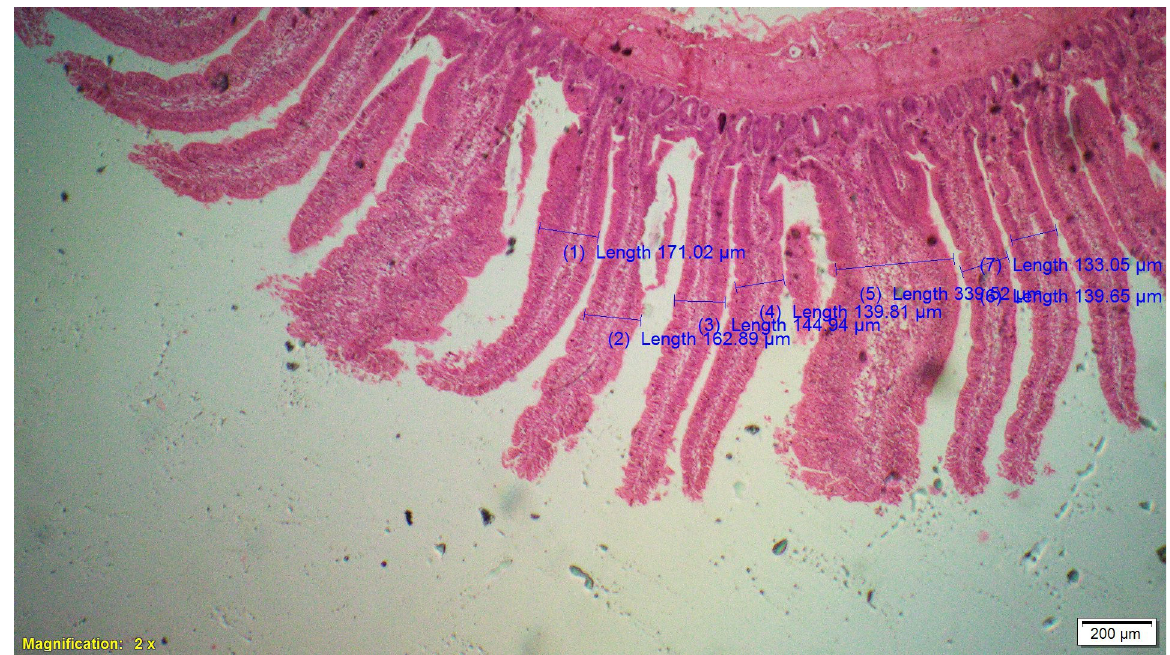
Fig 4. Photomicrograph of the cross section of Jejunum from probiotic + coriander group (T4), H&E, 2x. https://doi.org/10.1371/journal.pone.0270231.g004 (MEP) significantly (P < 0.05) increased the Lactobacilli counts than control and antibiotic in broilers. In contrary, supplementation of probiotic did not have significant (P < 0.05) effect in cecal Lactobacilli counts of broilers [29].